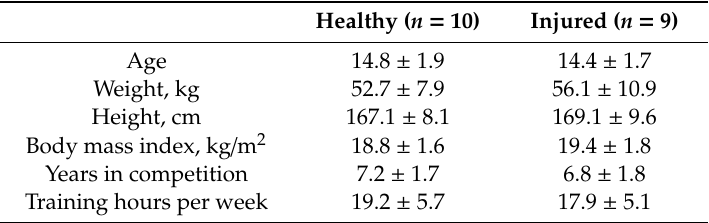
Table 1. Participant characteristics a